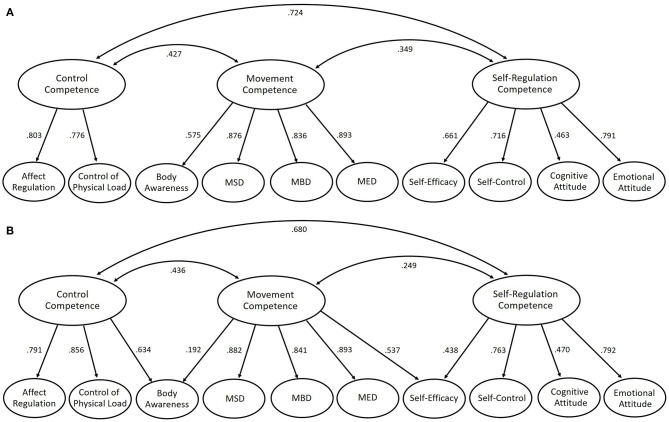
Second-order confirmatory factor analysis (CFA) modeling with the 10 first-order factors (A) and a one-on-one allocation (simple structure) (B) and two theory-conform cross-loadings. The item level and the correlations between the first-order factors have been omitted in this figure for presentation reasons. The loadings can be retrieved from Tables 2, 3, respectively, whereas the manifest correlations can be taken from Appendix Table 4.